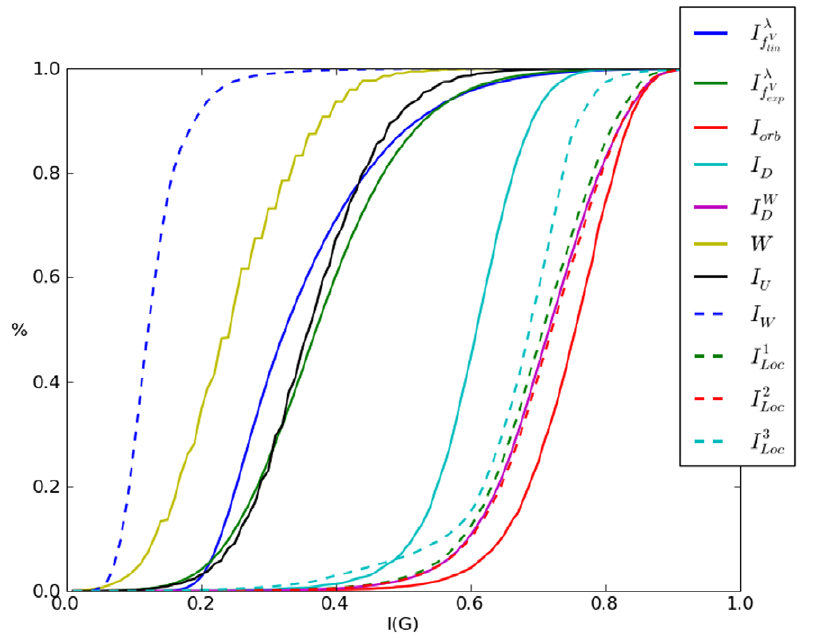
Figure 8. Cumulative Entropy Distribution for APL 91075. (reference label: cum_plot3).